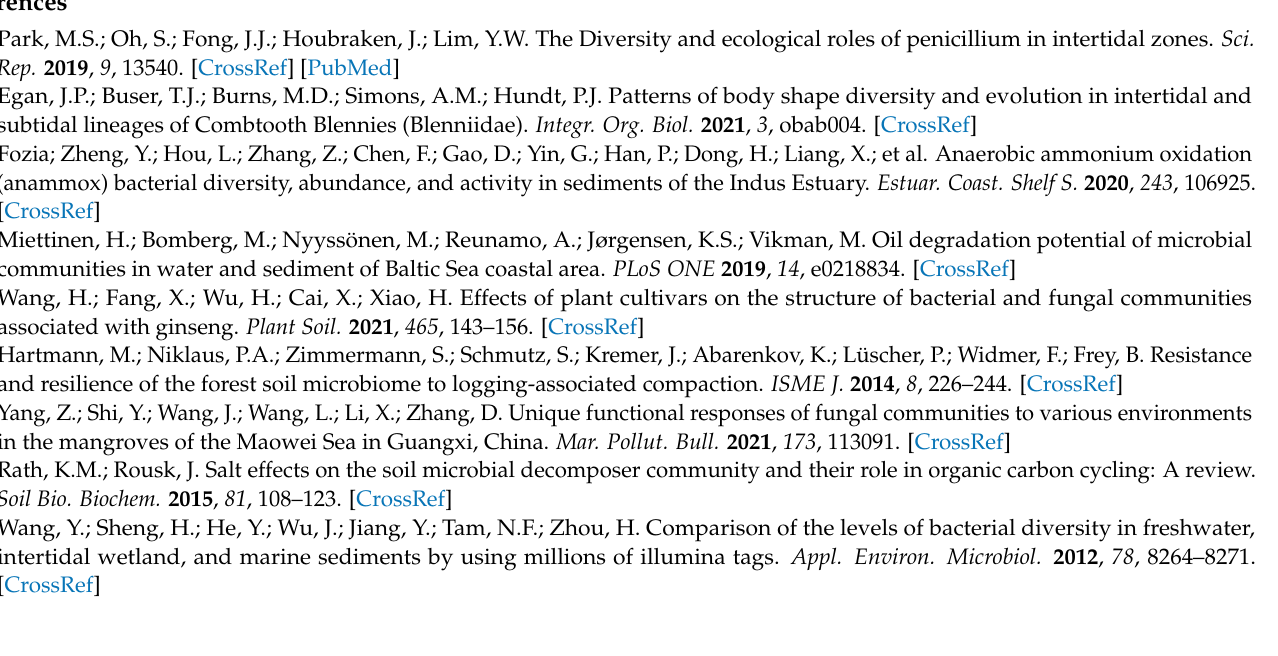
Figure S2: Fungal community composition (A) and distribution (B) at the phylum level in 33 coastal sediment samples from 11 different sites (S1–S11) from Guangdong, South China; Figure S3: PCoA analysis of fungal communities in 11 coastal sediments (S1–S11) from